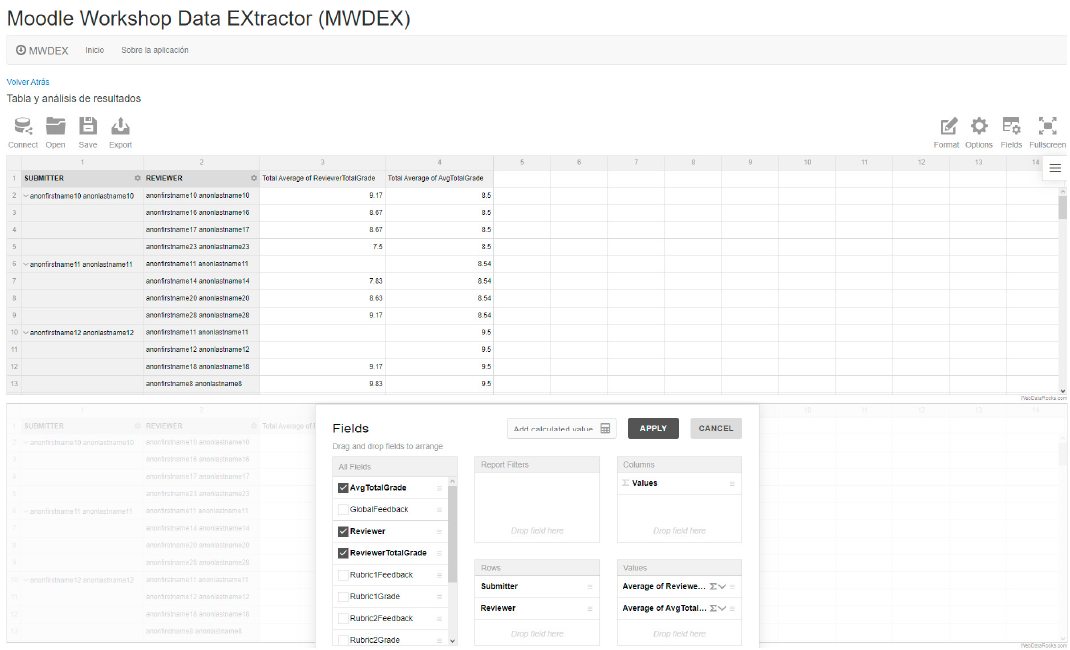
Figure 11. WebDataRocks (WDR) based interactive pivot table in MWDEX (top, main data visualization screen and bottom, field options).